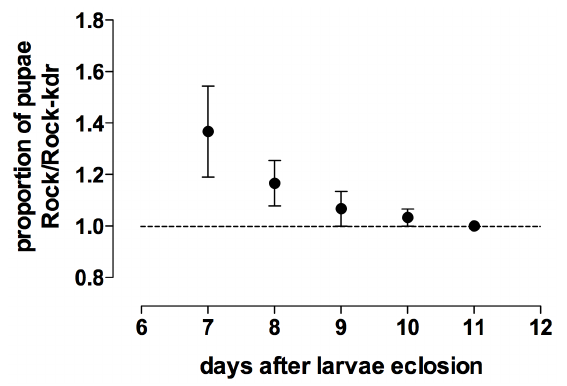
Figure 3 . Comparison of larval development time between Rockefeller and Rock-kdr Ae.aegypti strains. Numbers represent the cumulative daily proportion of Rock and Rock-kdr pupae formation after larvae eclosion under standard laboratory conditions. SEM is indicated. Gray dotted line indicates equal proportion (rate=1) between strains.